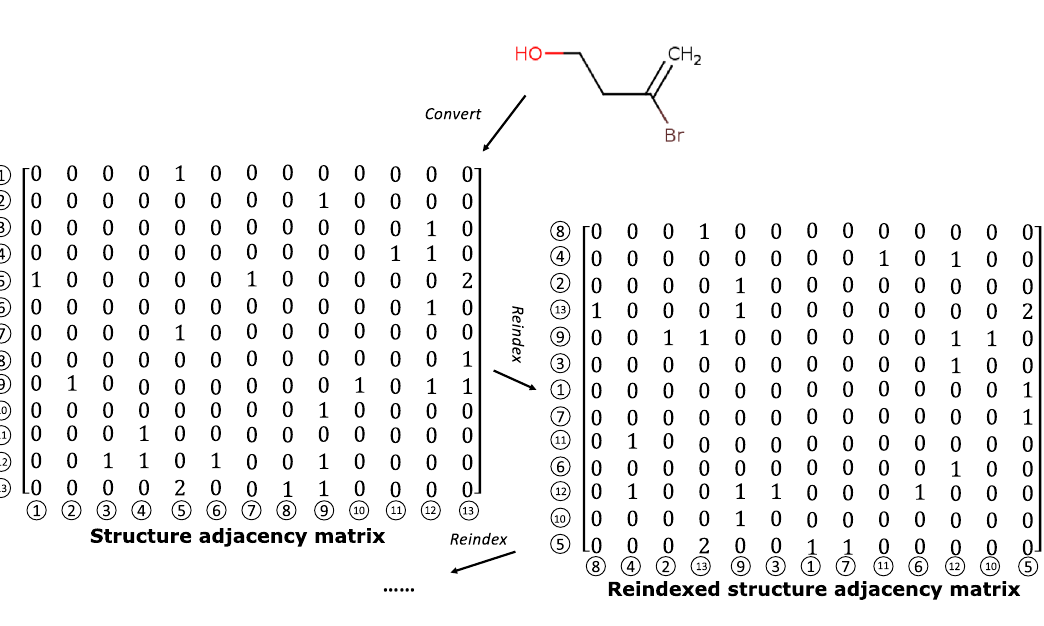
Figure 1. An example of the expander